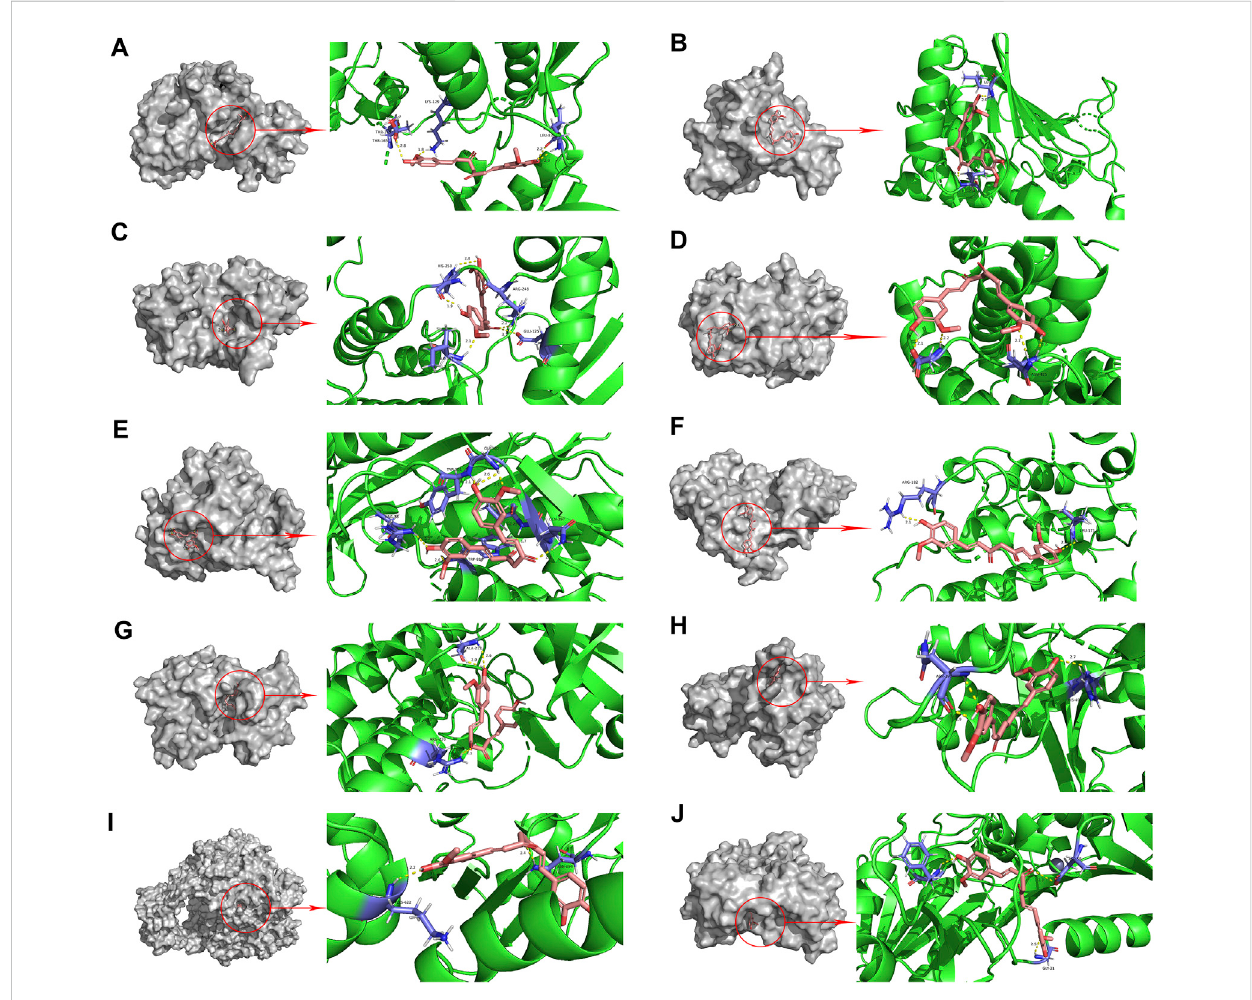
FIGURE 6 Molecular docking pattern of curcumin and core target protein. ( (A) . Curcumin-CDK2, (B) . Curcumin-HSP90AA1, (C) . Curcumin-AURKB, (D) . Curcumin-CCNA2, (E) . Curcumin-TYMS, (F) . Curcumin-CHEK1, (G) . Curcumin-AURKA, (H) . Curcumin-DNMT1, (I) . Curcumin-TOP2A, (J) .